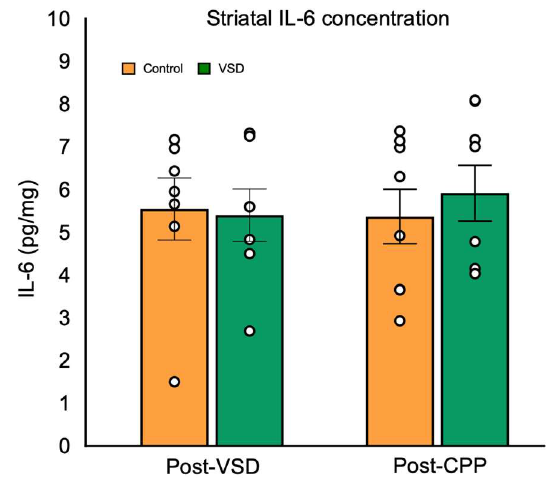
Figure 9. Vicarious Social Defeat (VSD) does not affect IL-6 levels in the striatum. Female mice were divided into control (n = 7 after VSD and n= 8 after CPP) and VSD (n = 7 after VSD and n= 8 after CPP). The bars represent the mean values ± SEM